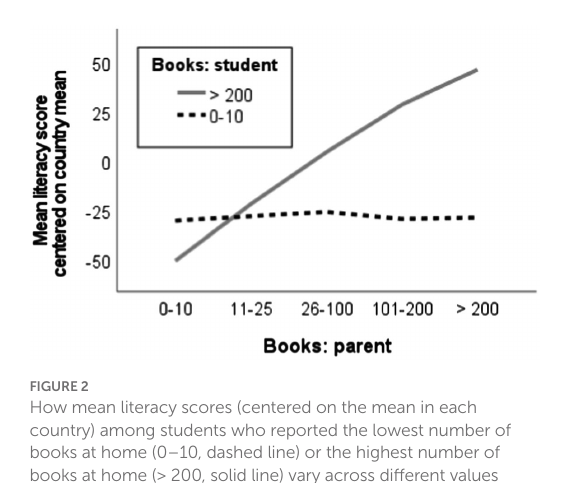
FIGURE 2 How mean literacy scores (centered on the mean in each country) among students who reported the lowest number of books at home (0–10, dashed line) or the highest number of books at home (> 200, solid line) vary across different values of books at home as reported by parents.